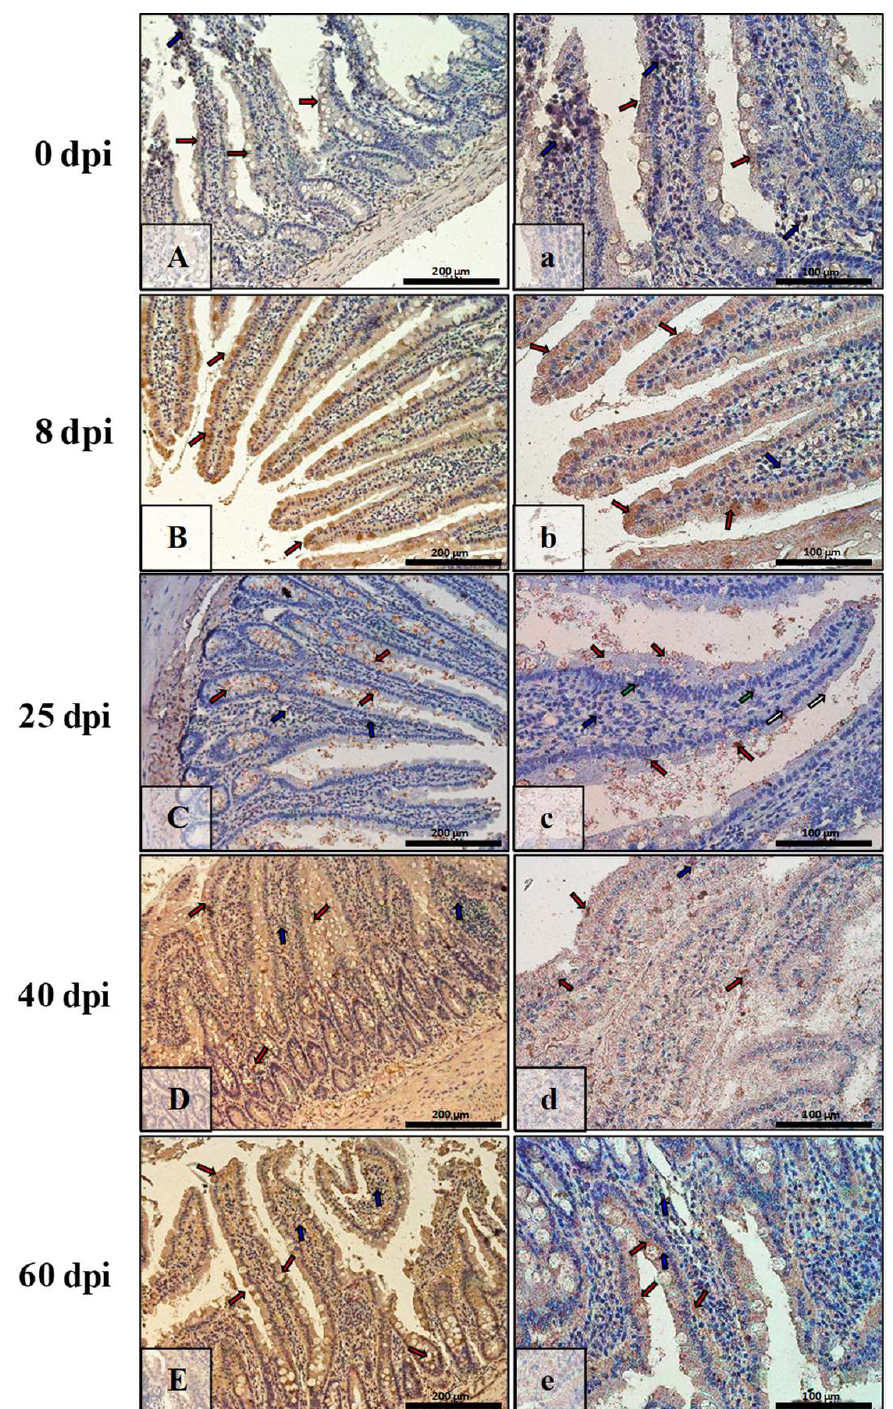
Figure 7. Representative microphotographs showing Bax immunoexpression in the small intestine of control animals ( A , a ) and on subsequent days ( B , b , C , c , D , d , E , e ) after H. diminuta infection. Positive IHC reaction—brown reaction marked with arrows: red—epithelial cells of the villi and intestinal crypts, blue and white—cells in the connective tissue lining of the mucosa, green—intraepithelial lymphocytes. Lens magnification: ×20 ( A – E , scale bar: 200 μm), ×40 ( a – e , scale bar: 100 μm).